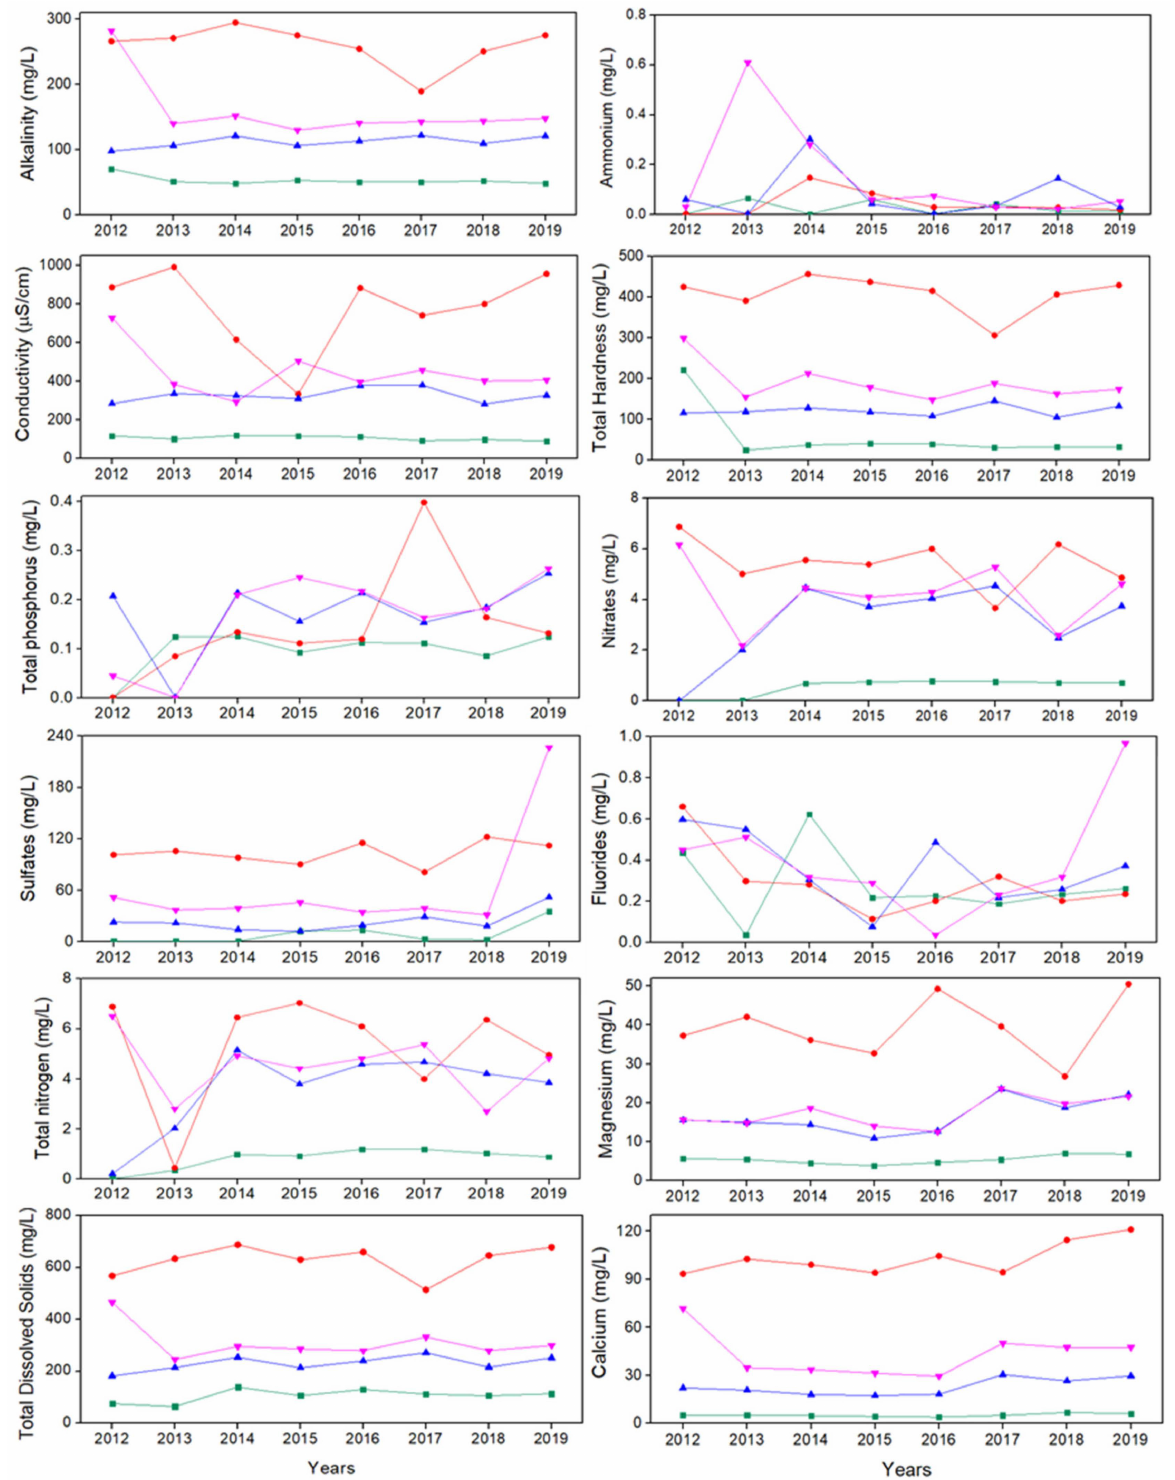
Figure 7. Variation of water quality parameters over time (2012–2019) at P1 (- (cid:4) -), P2 (- • -), P3 (- (cid:78) -) y P4 (- (cid:72)